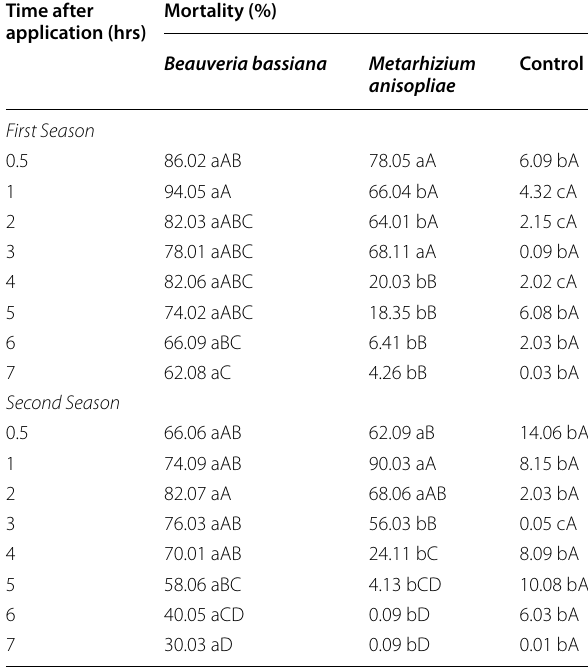
Table 2 Persistence of the fungus in relation to time after application for the percentage of mortality in Helicoverpa armigera in the first (2018) and second (2019) seasons Time after Mortality application (hrs)